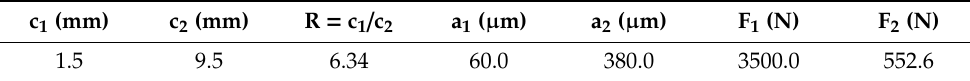
Table 1. Lever length, amplification ratio, and output force calculation.